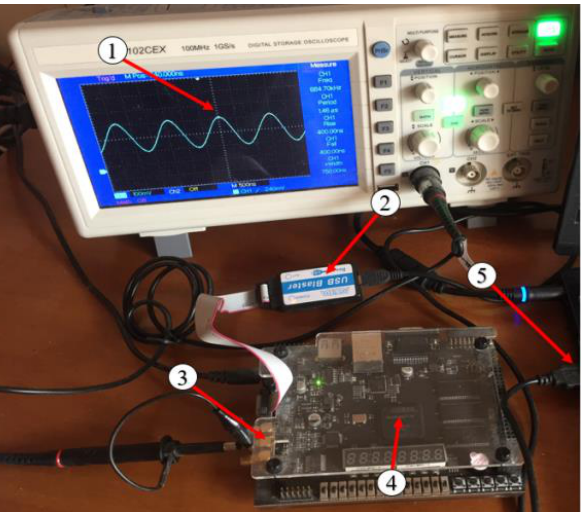
Figure 5. Experiment setup of FPGA implementation of the cosine waveform: (1) Oscilloscope; (2) FPGA USB blaster; (3) DAC output; (4) Cyclone IV E FPGA; (5) Connection to a PC.